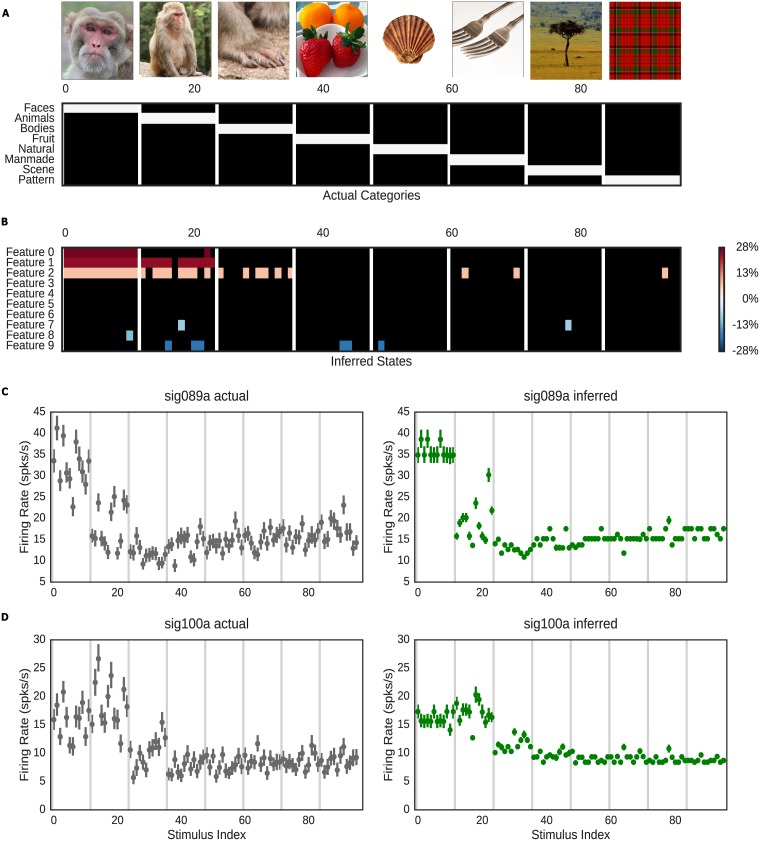
Comparison of actual and inferred states of the macaque dataset.A: Experimenter-determined features for the IT data set. 96 stimuli comprising 8 categories were presented in 1483 trials, with each stimulus presented to each neuron ∼15 times. B: The inferred states from our model. Color represents the mean percent change in firing rate across the population in response to each feature. For clarity, features with mean population effects <5% are not plotted. The model has inferred features corresponding to monkey close-ups, whole monkey photos, and most close-ups of monkey body parts. C: Actual and predicted spikes per second across all stimulus of neuron 089a. D. Actual and predicted spikes per second across all stimulus of neuron 100a. Error bars for data represent 95% credible intervals for firing rates inferred from observed data using a Poisson model with weak priors. Error bars on predictions are 95% credible intervals based on simulation from the approximate posterior for the plotted unit. Images copyright Geoff Gallice, kimubert/Flickr, dvs/Flickr, Julien Harneis, and Celtus/WikiMedia under CC-BY. Second and third monkey images copyright J.M. Garg (used with permission).